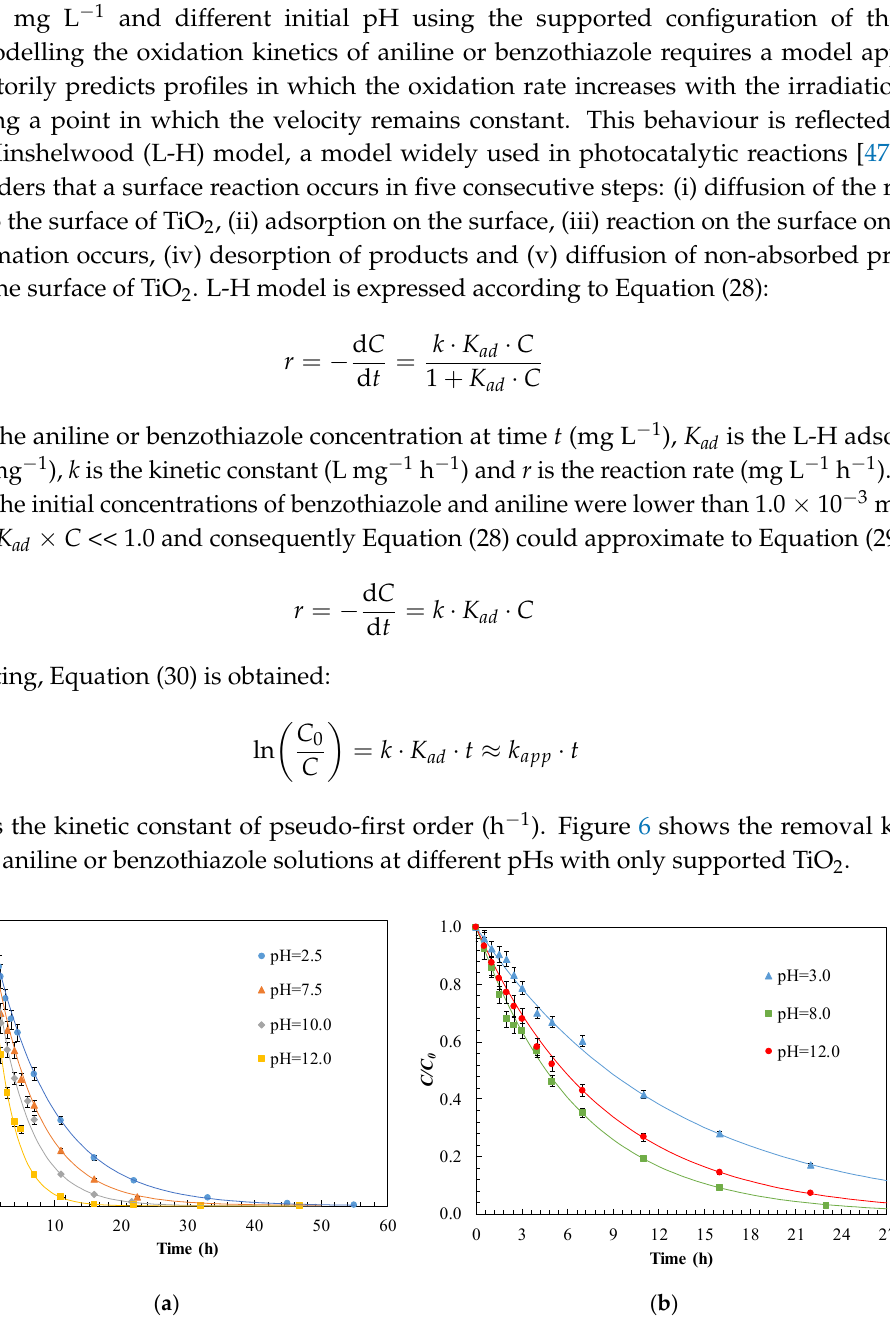
Figure 6. Effect of pH on the photocatalytic degradation of; ( a ) aniline and ( b ) benzothiazole, using only TiO 2 -supported catalyst. Experimental (dots) and pseudo-1st-order modelled ( ——— ) kinetic results. Conditions: C 0 = 22.0 mg L −1 ; T = 25.0 °C; P = 1.0 atm.